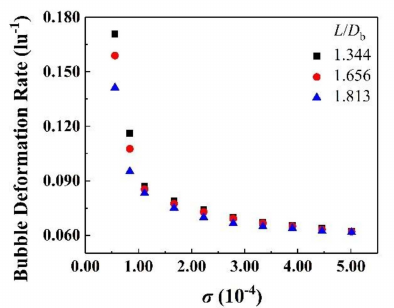
Figure 9. Variation of bubble deformation rate with surface tension at Re Gr = 100 and Eo = 20.